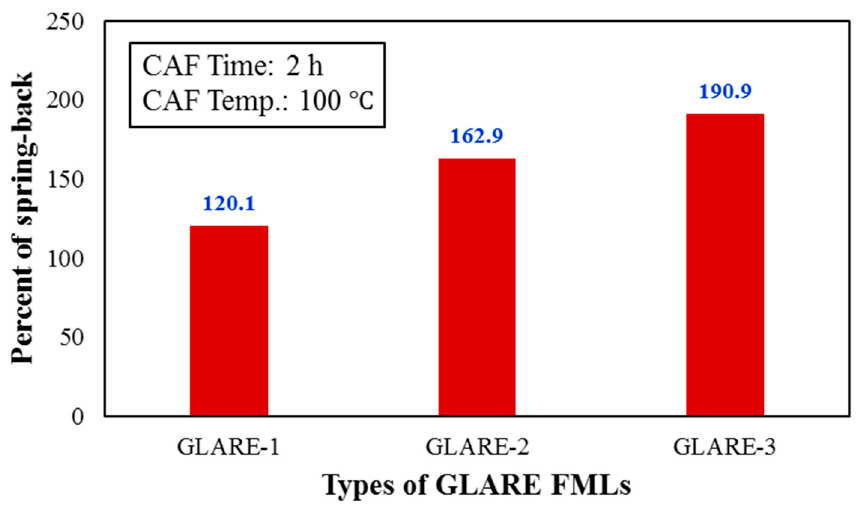
Figure 5. Effect of thickness of composites layer on the springback behavior of GLARE FMLs at CAF time 2 h and temperature 100 °C.